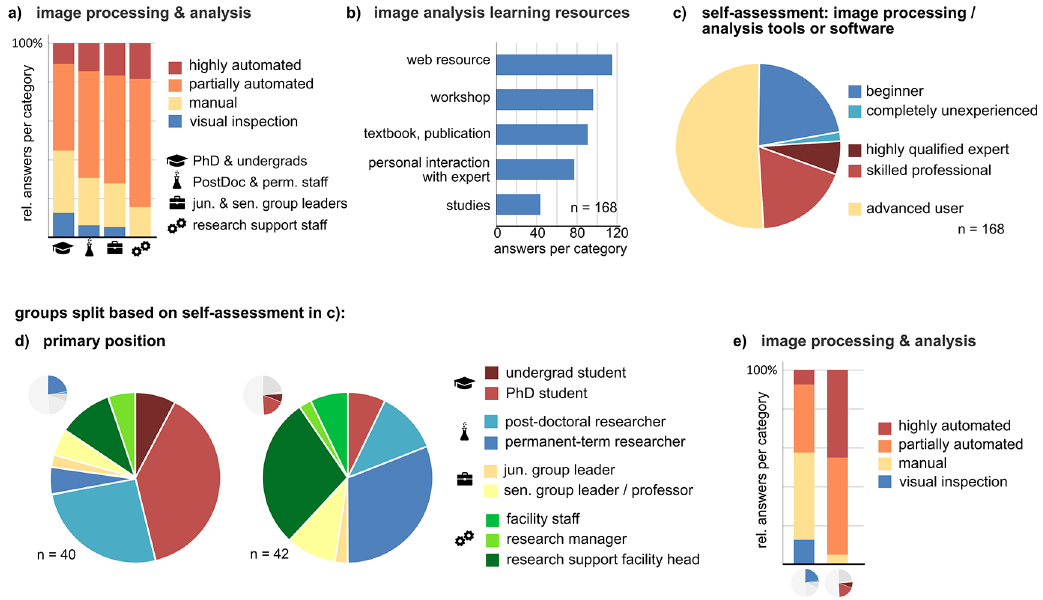
Figure 3. Role of bioimage analysis and aspects of autonomous processing and analysis. 35 a) Mode of image analysisby autonomous users and (b) their sources information for learning bioimage analysis procedures (n = 168). c) Self-reported skill levels in bioimage analysis of autonomous users, and (d, e) comparison between skilled professionals/qualified experts (n = 42) vs. inexperienced and beginners (n =